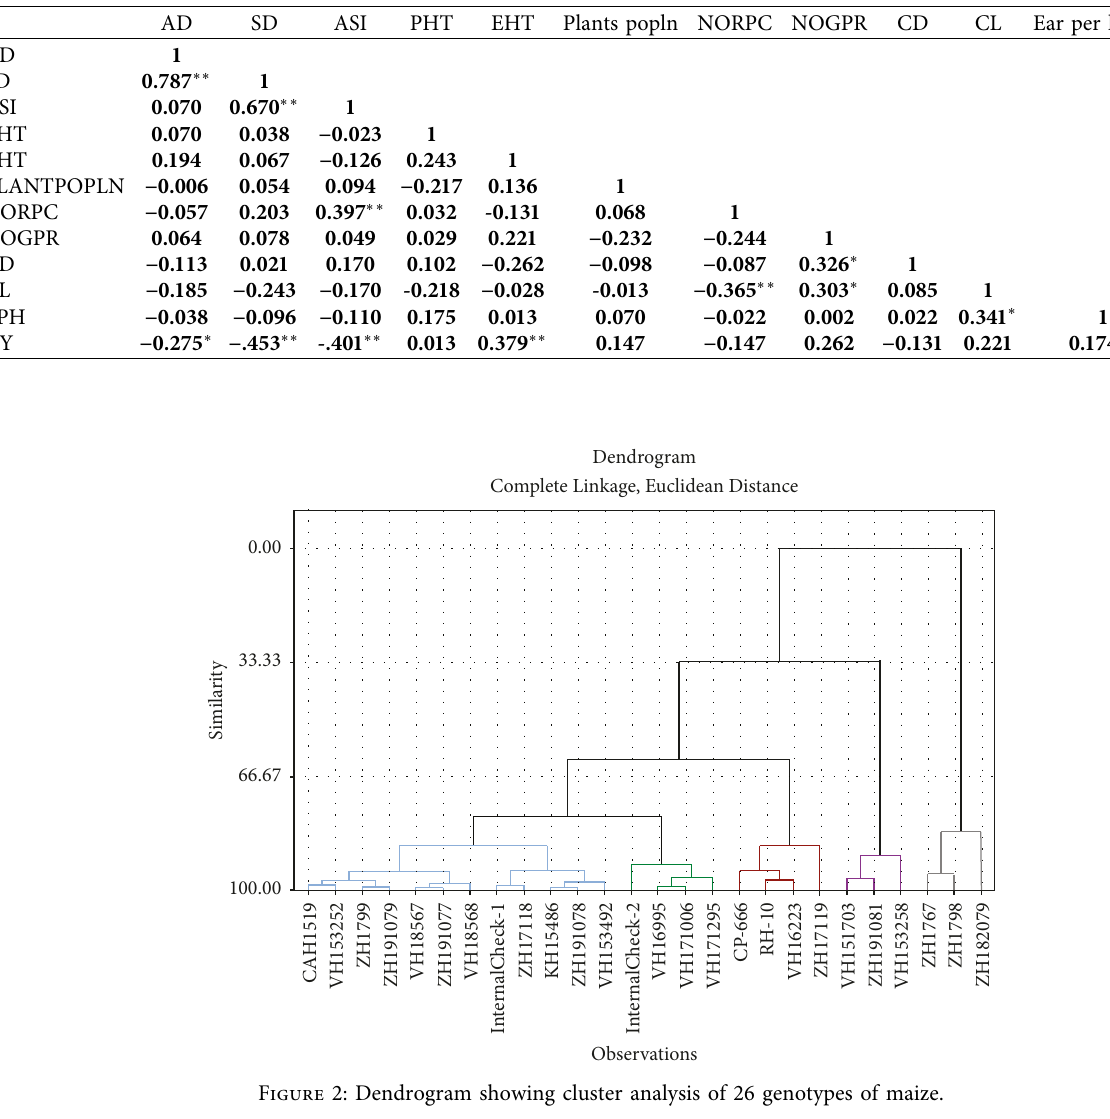
Table 4: Phenotypic correlation among yield and yield-attributing traits.